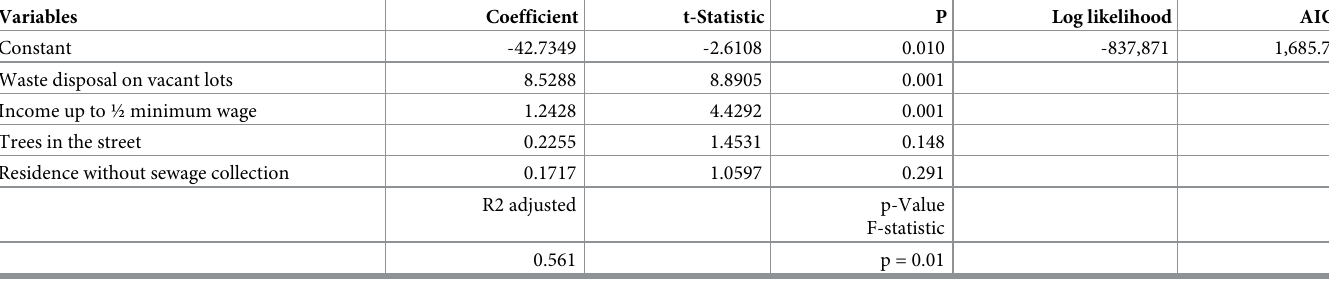
Table 4. Ordinary Least Squares (OLS) Regression of leishmaniasis incidence rates by census sector in Caratinga area (all districts).